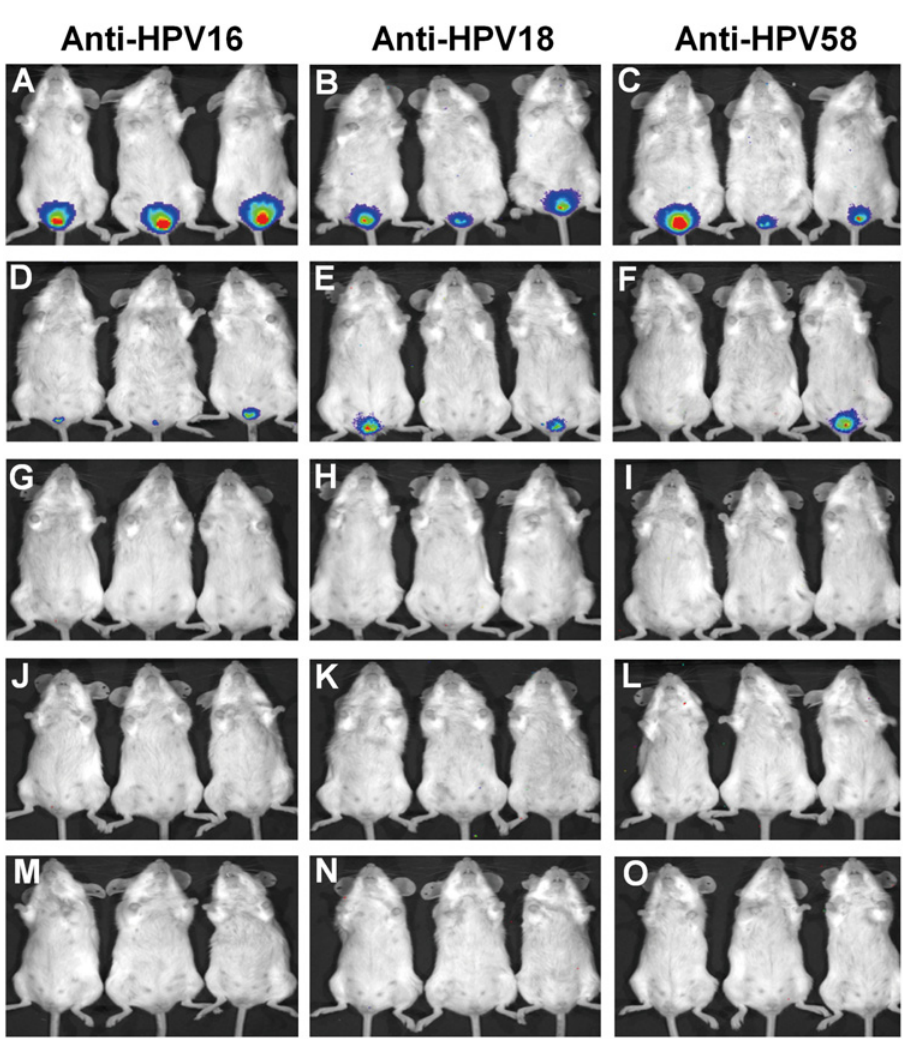
Fig 7. Vaginal challenge of AcHERV-triHPV-immunized mice with PVs. Mice were administered AcHERV-triHPV or PBS (control) three times over a 2-week interval by the SL or IM route. (A-C) Mice sublingually administered PBS. (D-L) Mice sublingually administered AcHERV-triHPV at a dose of 1×10 8 copies (D-F), 1×10 9 copies (G-I), or 1×10 10 copies (J-L). (M-O) Mice intramuscularly immunized with 1×10 9 copies. Eight weeks after the first immunization, mice received vaginal challenge with luciferase-expressing PV16 (A,D,G,J,M), PV18 (B,E,H,K,N), or PV58 (C,F,I,L,O). Three days after the challenge, mice were anesthetized and injected with luciferin, and the levels of luminescence were detected with an IVIS 200 bioluminescence imaging system.